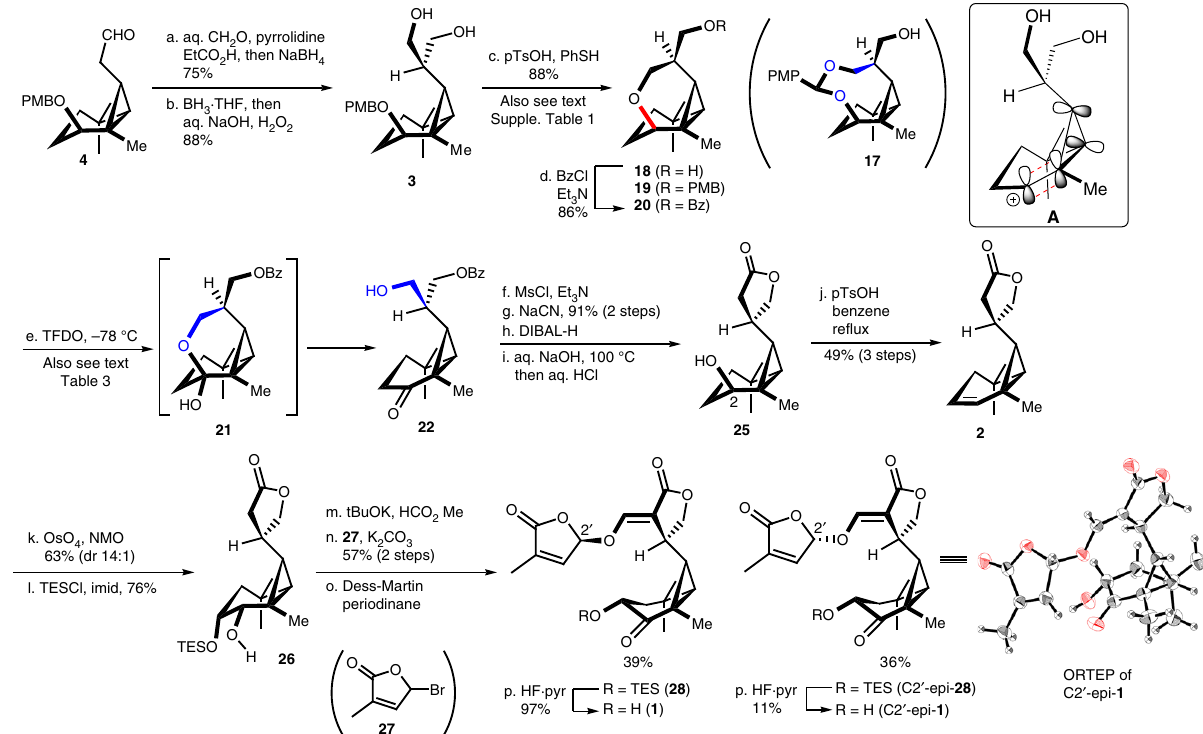
Fig. 5 Total synthesis of avenaol ( 1 ). Conditions: a aq. CH 2 O, pyrrolidine, EtCO 2 H, i PrOH, 45 °C, then NaBH 4 , MeOH, 0 °C, 75%; b BH 3 · THF, then aq. NaOH, aq. H 2 O 2 , 88%; c p- toluenesulfonic acid, PhSH, CH 2 Cl 2 , 88%; d BzCl, Et 3 N, DMAP, CH 2 Cl 2 , 86%; e TFDO, CH 2 Cl 2 , − 78 °C, f mesyl chloride, Et 3 N, CH 2 Cl 2 ; g NaCN, 15-crown-5, DMSO, 91% (two steps); h diisobutylaluminium hydride, THF, − 20 °C; i aq. NaOH, 100 °C, then 1 M aq. HCl; j p- toluenesulfonic acid, benzene, re fl ux, 49% (three steps); k OsO 4 , 4-methylmorpholine N -oxide, acetone – t BuOH – H 2 O, 63% (dr 14:1); l TESCl, imidazole, DMF, 76%; m t BuOK, HCO 2 Me, THF; n 5-bromo-3-methylfuran-2-one, K 2 CO 3 , 1-methyl-2-pyrrolidinone, 57% (two steps), dr 1:1; o Dess – Martin periodinane, CH 2 Cl 2 – pyr, 39% (for 28 ) and 36% for (C2 ′ -epi- 28 ); p HF · pyr, THF, 97% (for 1 ), 11% (for C2 ′ epi- 1 ). Bz Benzoyl, TES triethylsilyl, TFDO methyl(tri fl